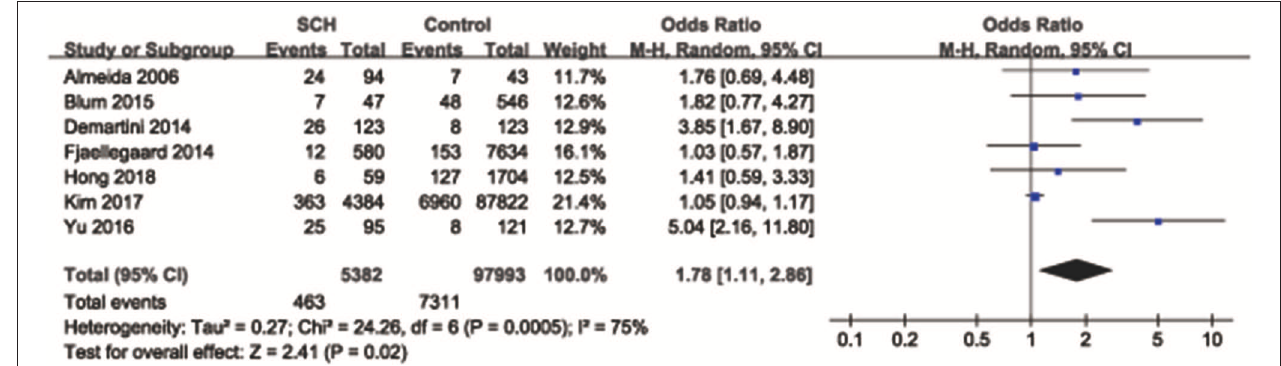
FIGURE 3 | Pooled analysis for subclinical hypothyroidism and depression. SCH, subclinical hypothyroidism; CI, confidence interval.